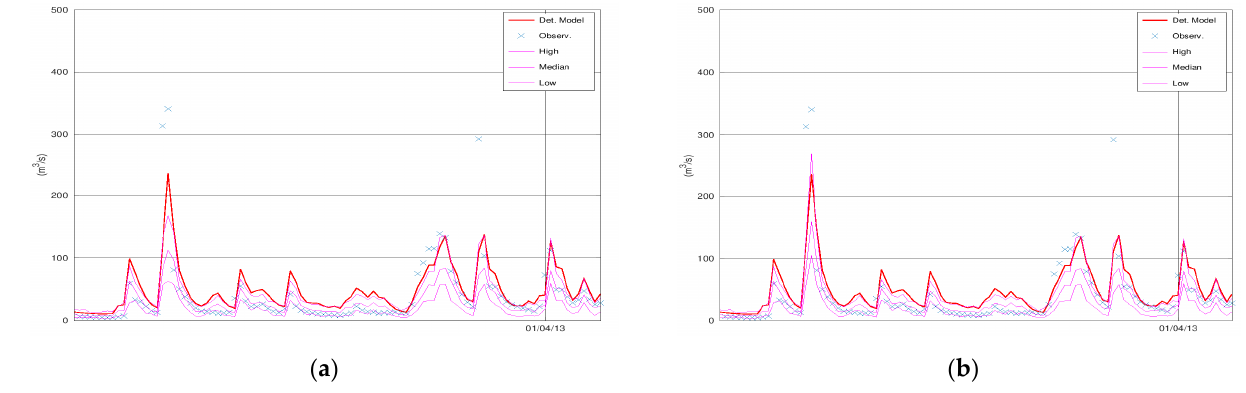
Figure A3. Discharge of Arno River, 100 daily time steps of the validation period starting from 1 January 2013: ( a ) KNN applied to the trimmed training data set; ( b ) KNN with linear extrapolation applied to the trimmed training data set. “Det. Model” is the simulation with HyMod.